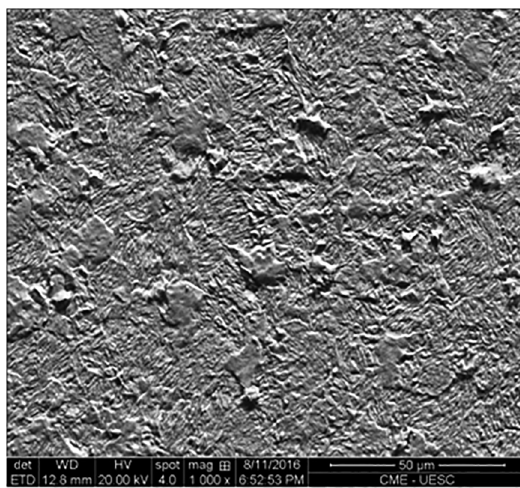
Figure 10. SEM micrograph of AISI 1020 carbon steel after 12 h immersion in Cl 0.5 mol.L -1 .